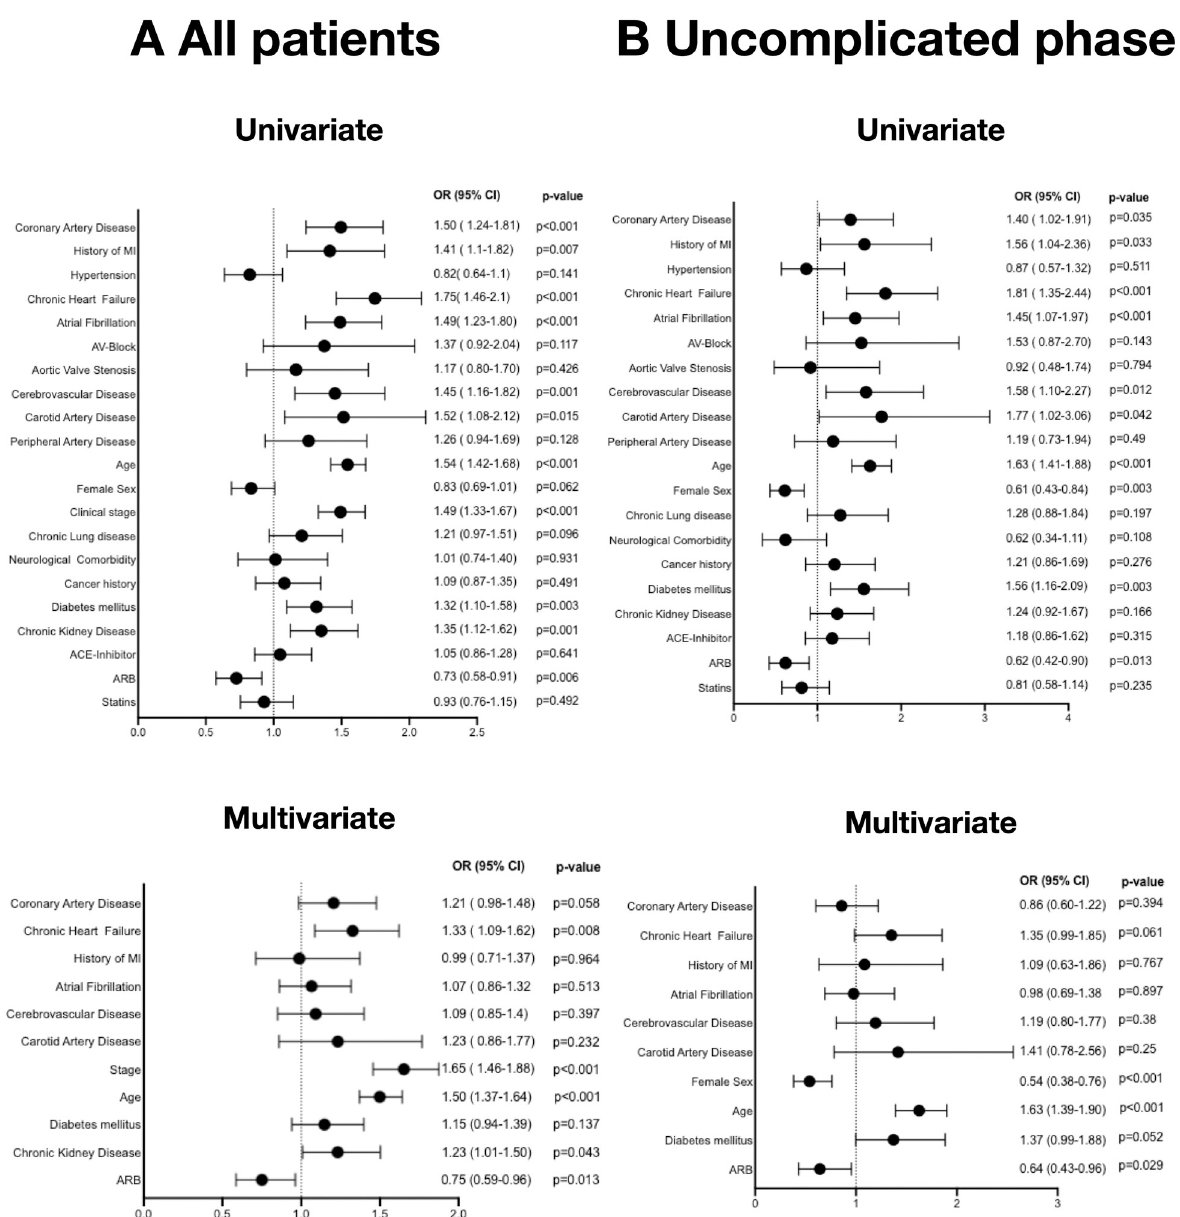
Fig 1. Mortality risk in patients with CVD and hypertension. Forrest plots of univariate and multivariate analysis for mortality risk for the given clinical characteristics of all included patients ( A ) and patients who presented in the uncomplicated phase at baseline (n = 1132) ( B)